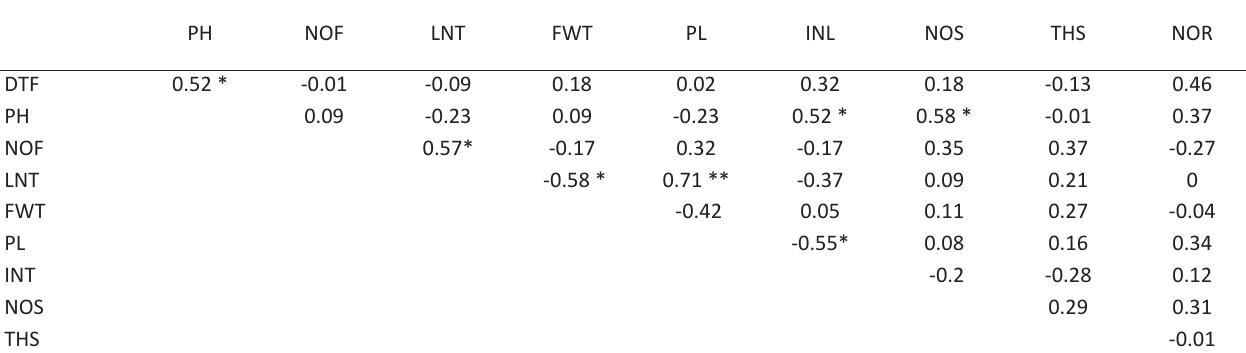
* and ** significant at p ≤ 0.05 and p ≤ 0.01 respectively; DTF, days to 50% flowering; PH, plant height at maturity; NOF, number of fruits per plot; LNT, fruit length; FWT, fruit circumference; PL, Pedicel length; INL, internodal length; NOS, number of seeds per pod; THS,